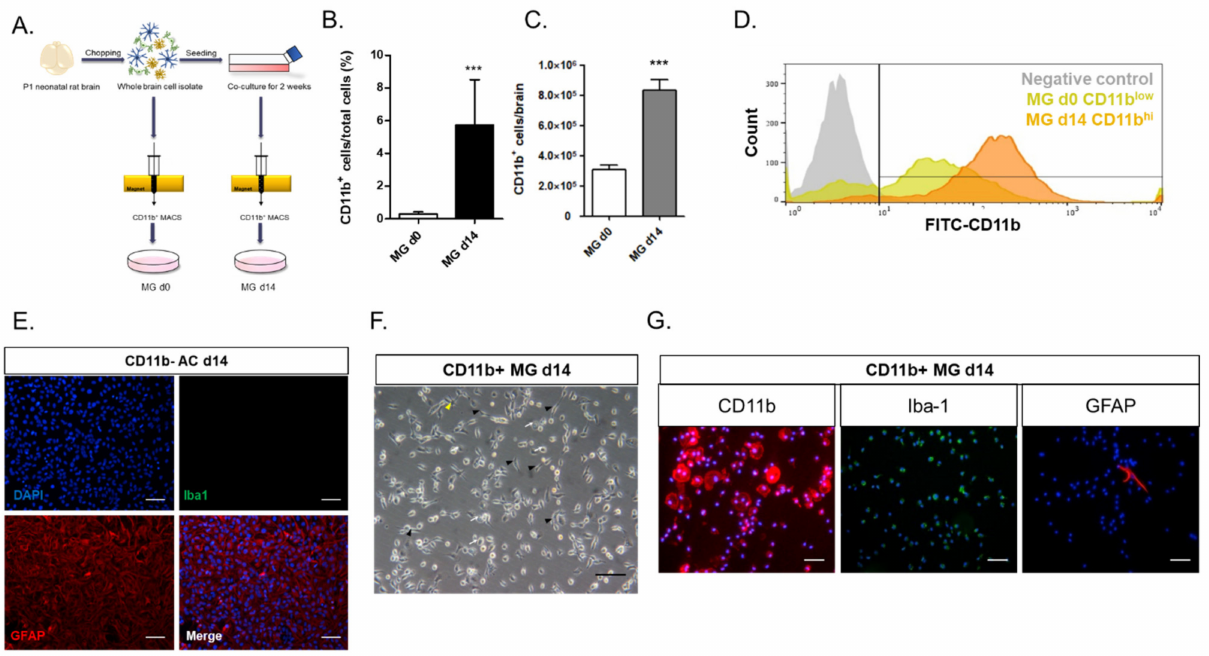
Figure 1. CD11b − /GFAP + astrocyte from whole brain culture induced microglial proliferation and activation: ( A ) the experimental scheme of microglial isolation by MACS. Day 0 microglia were isolated immediately from whole brain cell isolates by CD11b+ MACS, and Day 14 microglia were isolated from the 2-week mixed glial cell culture; ( B ) the CD11b + cell yield of MG d0 and MG d14 ( n = 11); ( C ) the numbers of CD11b + cells per brain for MG d0 and MG d14 ( n = 11); ( D ) flow cytometry analysis of MG d0 and MG d14 with the microglia-specific marker CD11b. Fluorescent intensity of CD11b was enhanced in MG d14 compared to that of MG d0; ( E ) fluorescence images for CD11b − cells sorted from the 2-week mixed glial cell culture stained for microglia-specific marker iba-1 and astrocyte-specific marker GFAP; ( F ) bright field image of MG d14. Yellow arrowhead: ramified microglia; black arrowhead: bipolar-shape microglia; white arrow: round-shape microglia; ( G ) fluorescence images of MG d14 stained with microglia-specific markers CD11b and iba-1 and astrocyte-specific marker GFAP. *** p < 0.001; scale bar = 100 µ